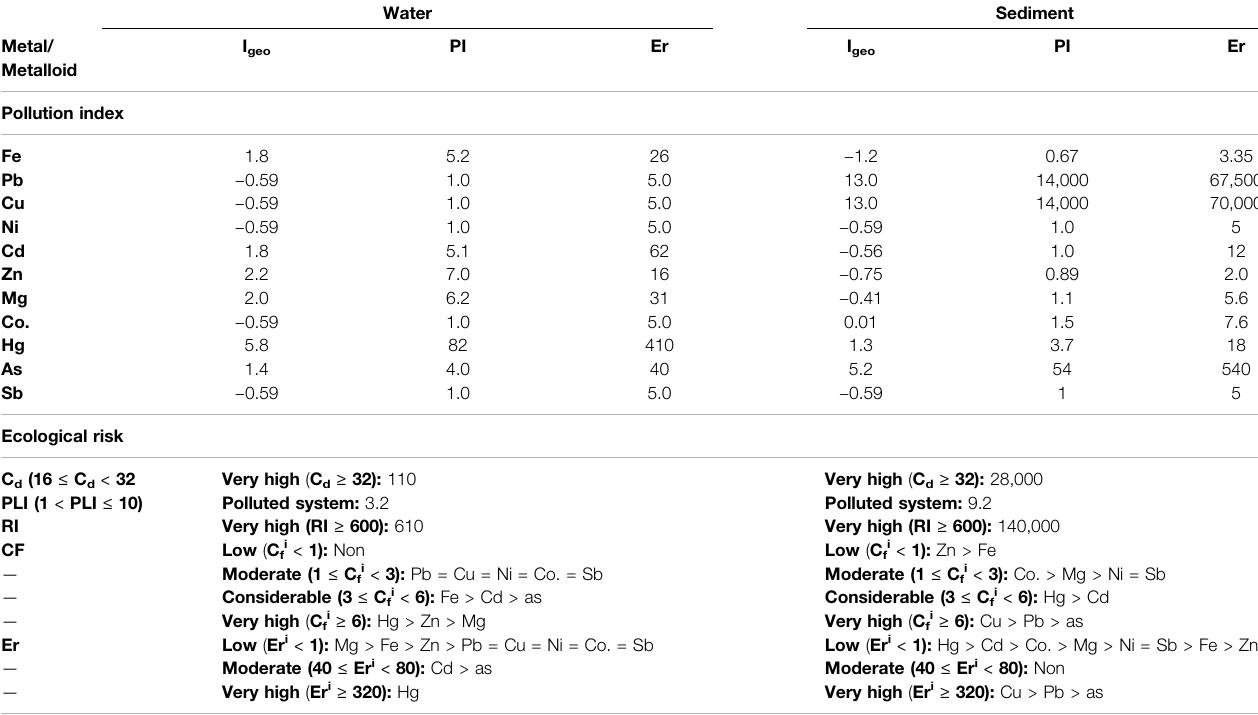
TABLE 2 | Heavy metal and metalloid pollution indexes and ecological risks of the textile wastewater impacted